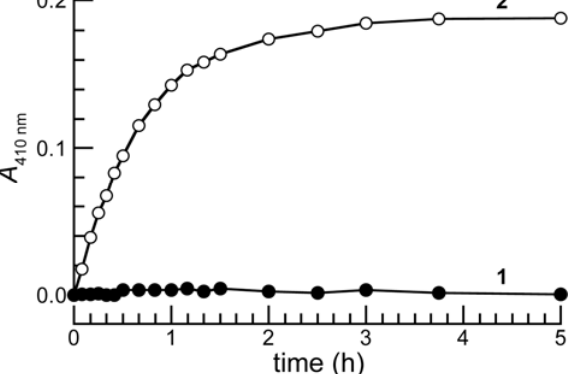
Figure 3. Time course for the mean change in the absorbance at 410 nm of prochromophore 1 (13 μ M) and p -nitrophenyl acetate ( 2 ) (13 μ M) in PBS containing BSA (1.0 mg/mL).